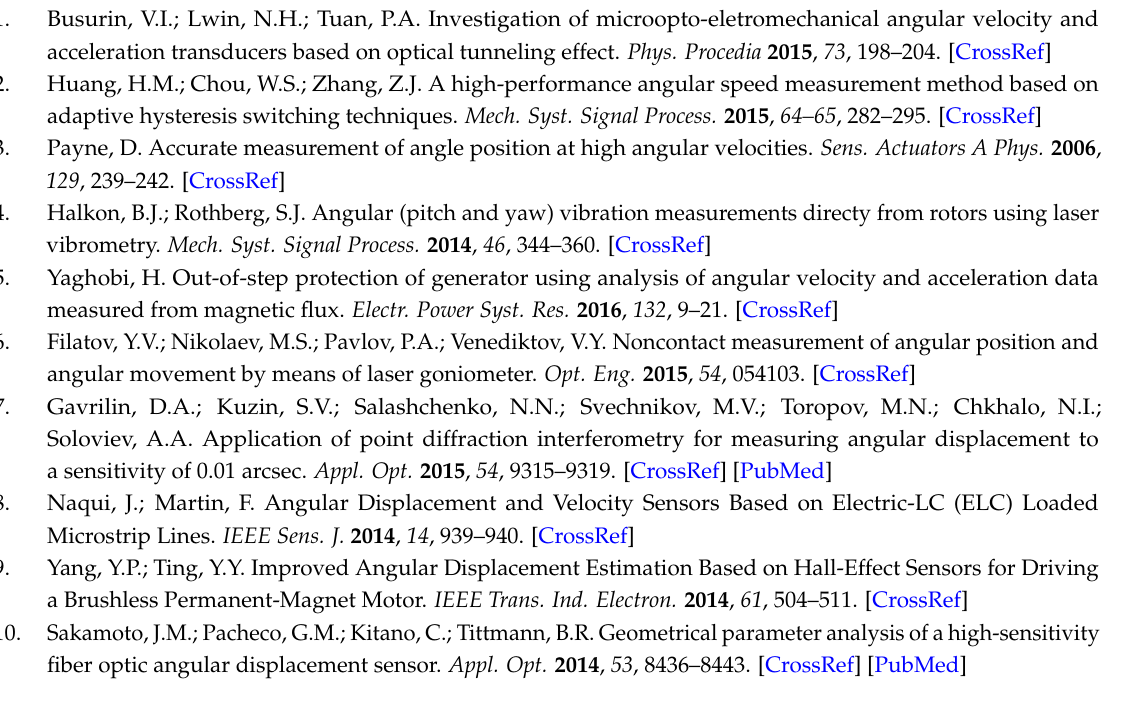
algorithm based on FPGA, and conducted semi-physical angular velocity simulation experiments. Dan Wu designed the triaxial electromagnetic induction coils, researched and developed the angular velocity sensor as well. Yan Han designed the physical angular displacement simulation